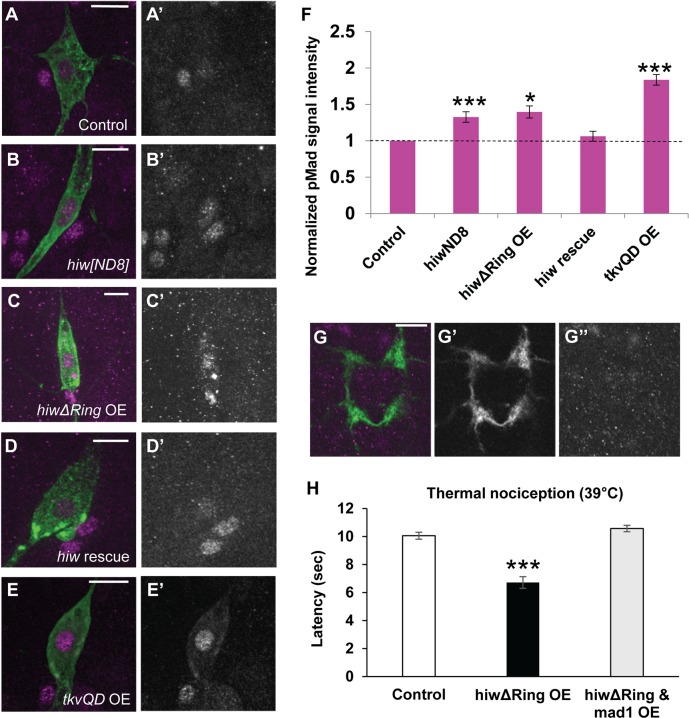
BMP signaling in nociceptors is negatively regulated at the downstream of hiw.(A-E) Representative images of pMad immunoreactivity in nociceptor cell bodies. Green represents mCD8::GFP and magenta shows pMad signals. (A’-E’) Split images for pMad signals. Scale bars represent 10 μm. (F) Quantification of nuclear pMad signals in nociceptors. hiwND8 mutants (hiwND8; ppk-GAL4 UAS-mCD8::GFP/+, n = 21) and hiwΔRing OE (ppk-GAL4 UAS-mCD8::GFP/+; UAS-hiwΔRing/+, n = 18) had 33 ± 7% and 40 ± 8% increases in nuclear pMad signals, respectively. No significant difference in nuclear pMad level compared to controls was detected in hiw rescue animals (hiwND8; ppk-GAL4 UAS-mCD8::GFP/UAS-hiw, n = 24). Nociceptors expressing tkvQD (ppk-GAL4 UAS-mCD8::GFP x UAS-tkvQD, n = 30) also showed significantly increased nuclear pMad levels (84 ± 7%). Control (ppk-GAL4 UAS-mCD8::GFP/+, n > 12) * p < 0.05, *** p < 0.001 (Mann-Whitney’s U-test). (G) A projection image of axon terminal of Class IV neurons at A4 and A5 segments in the larval ventral ganglia. Green represents mCD8::GFP and magenta shows pMad signals. pMad signals at axon termini in nociceptors were not distinguishable from the background. (G’) Split image for mCD8::GFP. (G”) Split image for pMad signals. Scale bar represents 10 μm. (H) Expression of mad1 suppressed the thermal hypersensitivity in hiwΔRing-expressing animals. Control (w1118
x ppk-GAL4, n = 73, 10.1 ± 0.3), hiwΔRing OE (ppk-GAL4 x UAS-hiwΔRing, n = 59, 6.7 ± 0.4) and hiwΔRing & mad1 OE (ppk-GAL4 UAS-hiwΔRing x UAS-mad1, n = 51, 10.6 ± 0.2). *** p < 0.001 (Steel’s test versus control). Error bars represent standard error.